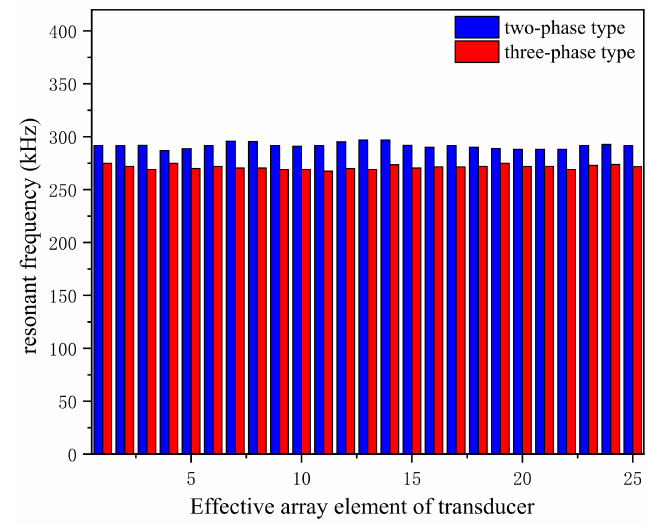
Figure 12. Transducer array element consistency test.